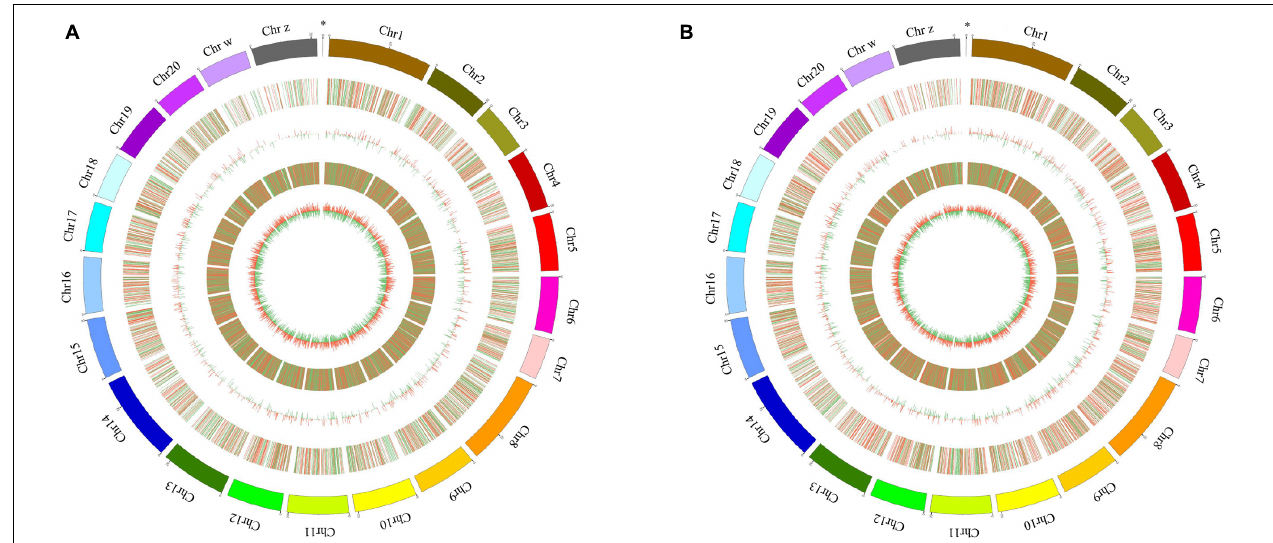
FIGURE 2 | Circos plot diagram of differential expressed (DE) lncRNA and mRNA in stage IV vs. V (A) and stage V vs. VI (B) . The outermost circle is the autosomal distribution of tongue sole; the second circle is the DE lncRNA on the chromosome, the red line represents up regulation, the green line represents down-regulation; the third circle is the histogram of DE lncRNAs at different positions. Red represents up regulation, green represents down regulation, and the higher column, indicates the more DE gene numbers. The fourth circle is the distribution of DE mRNAs on the chromosome, and the color distribution is the same as lncRNA; the innermost circle is the column with DE mRNAs at different positions, color distribution is the same as lncRNA. The “ ∗ ” represents mitochondrion genome.